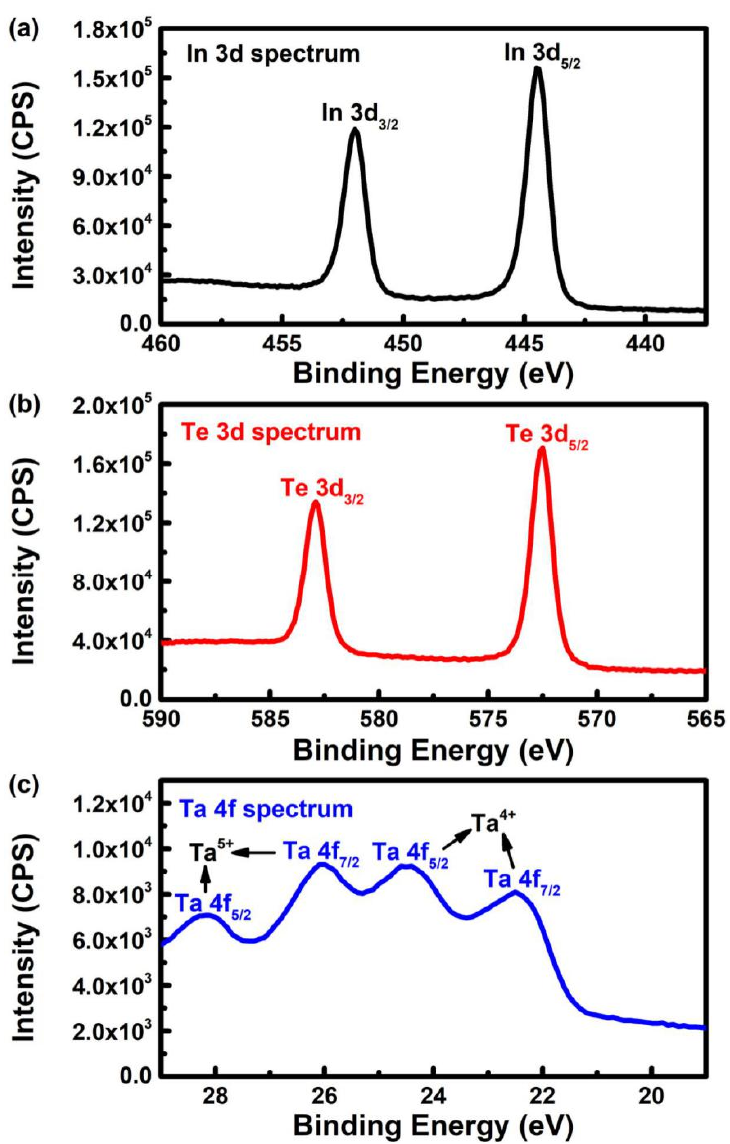
Figure 5. XPS spectra of S3: ( a ) In 3d, ( b ) Te 3d, and ( c ) Ta 4f regions.